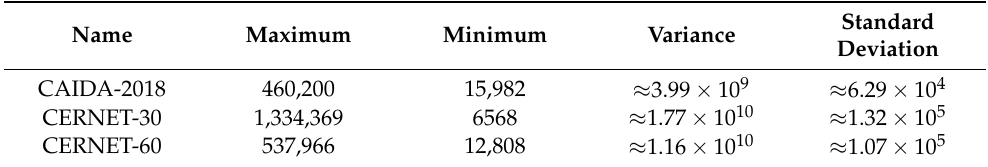
Table 3. The flow size distribution information about the experimental